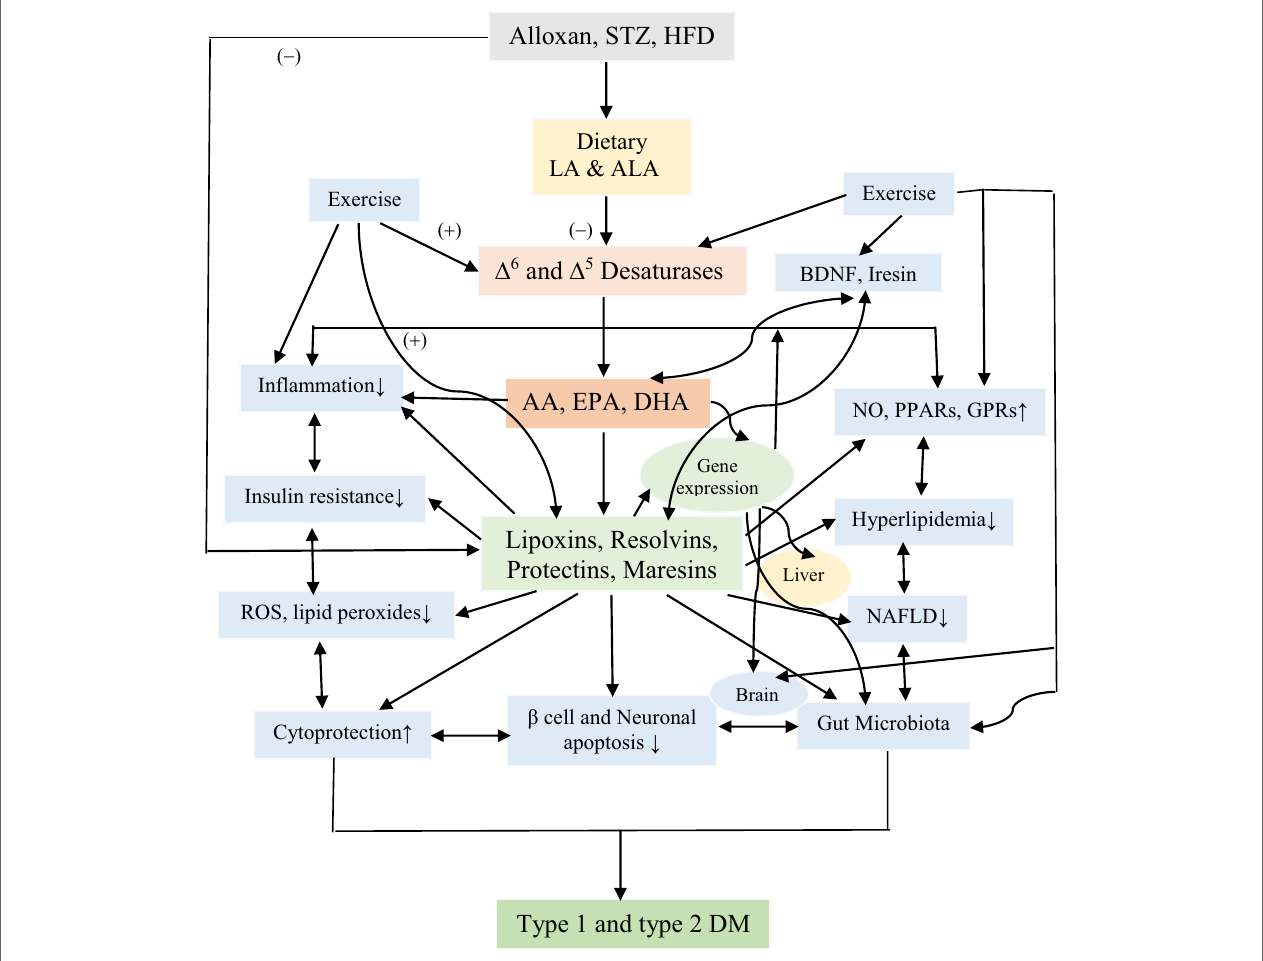
FiGUre 14 | Scheme showing actions of polyunsaturated fatty acid and their anti-inflammatory products: lipoxins (LXs), resolvins, protectins, and maresins on various factors that have a role in the pathobiology of type 1 diabetes mellitus (type 1 DM) and type 2 diabetes mellitus (type 2 DM). ( − ) indicates inhibition of action or negative control. ( + ) indicates increase in action or synthesis or positive control. Exercise enhances the formation and action of brain-derived neurotrophic factor (BDNF), LXs, resolvins, protectins, and maresins and suppress inflammation and reduces insulin resistance. BDNF, LXs, resolvins, protectins and maresins suppress inflammation, reduce insulin resistance, and protect pancreatic β cells from the cytotoxic action various endogenous and exogenous cytotoxic molecules/agents. Alloxan, streptozotocin, and high-fat diet suppress the activities of desaturases and reduce the formation of LXs, resolvins, protectins, and maresins and their precursors and the formation and action of BDNF (for details see